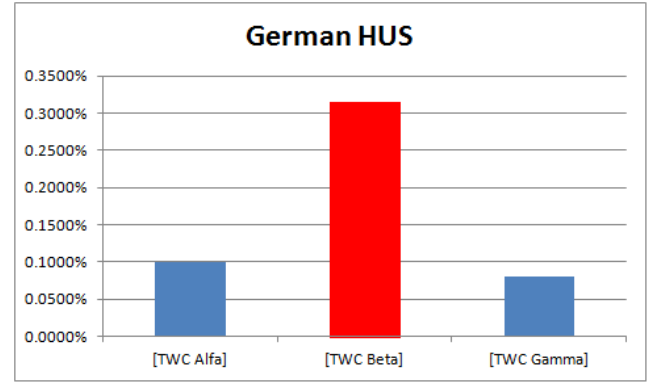
Figure 19. German HUS: estimations of the hot areas of diffusion of the epidemic according to TWC α , β and γ